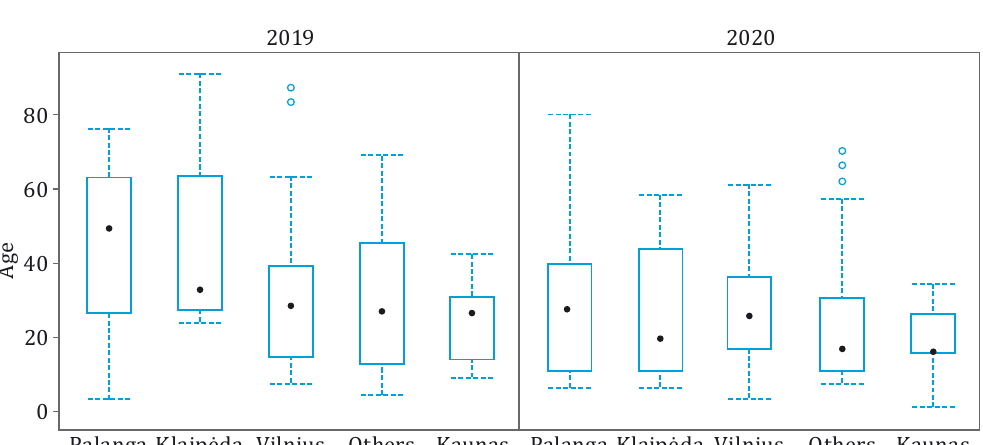
Figure 2. Age distribution of injuries in e-scooter-involved accidents Palanga PalangaKlaipėda Klaipėda by city and year